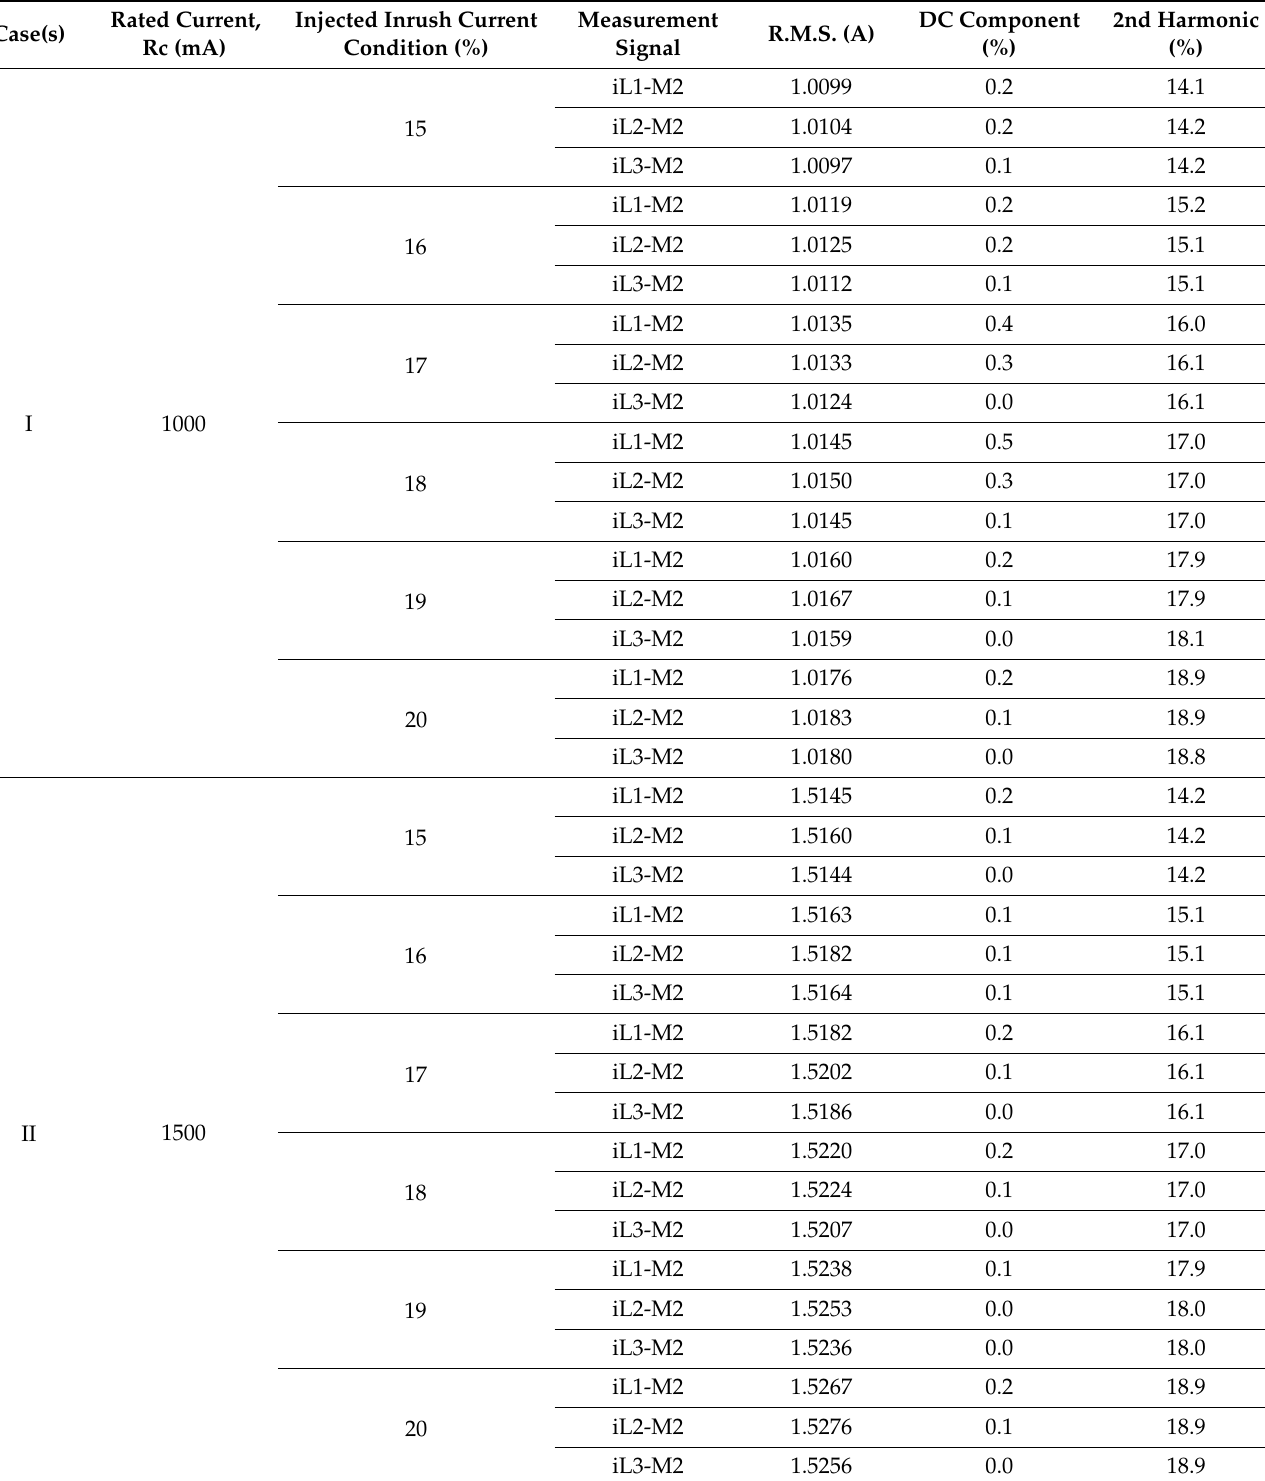
Table 1. Harmonics blocking in lines (L1, L2, &